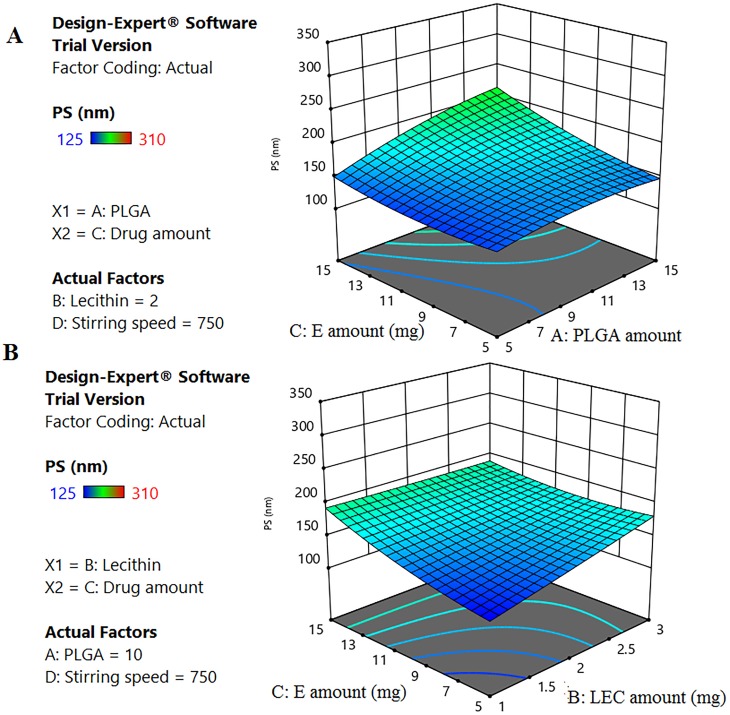
Response 3D plot for the significant parameters interaction on ELPH PS (Y1).Interaction of (AB) between PLGA and E (A). Interaction of (BC) between LEC and E (B). The positive interaction between PLGA and E indicates an enhanced effect of both variables on LPH PS. On the contrary, LEC-E interaction shows an antagonistic effect on PS.